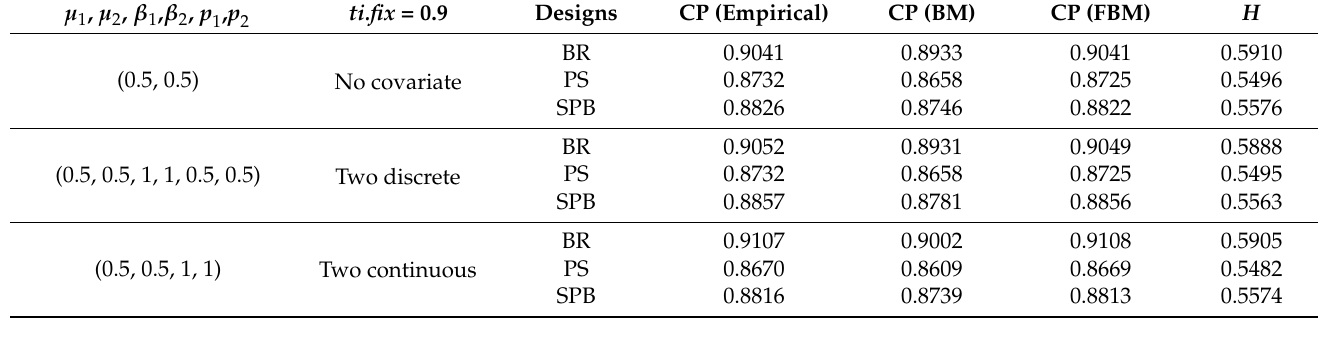
Table 8. CPs under misspecification scenarios: ε ’s ~increments of FBM, H = 0.9, drift = 1.5, ti.fix = 0.9.